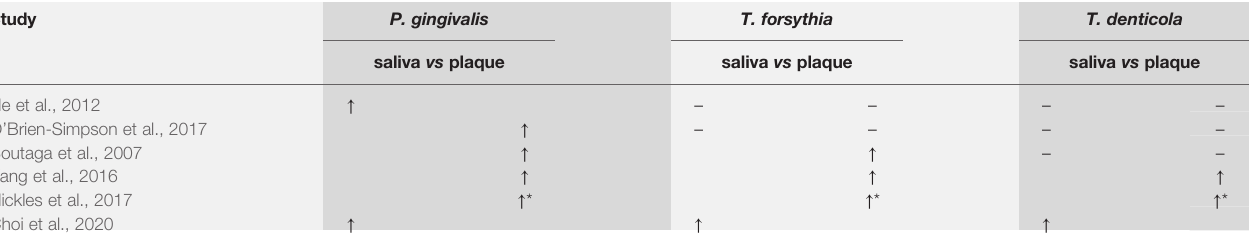
TABLE 3 | Comparisons of bacterial counts of the red complex species between saliva and subgingival plaque samples from periodontitis patients.